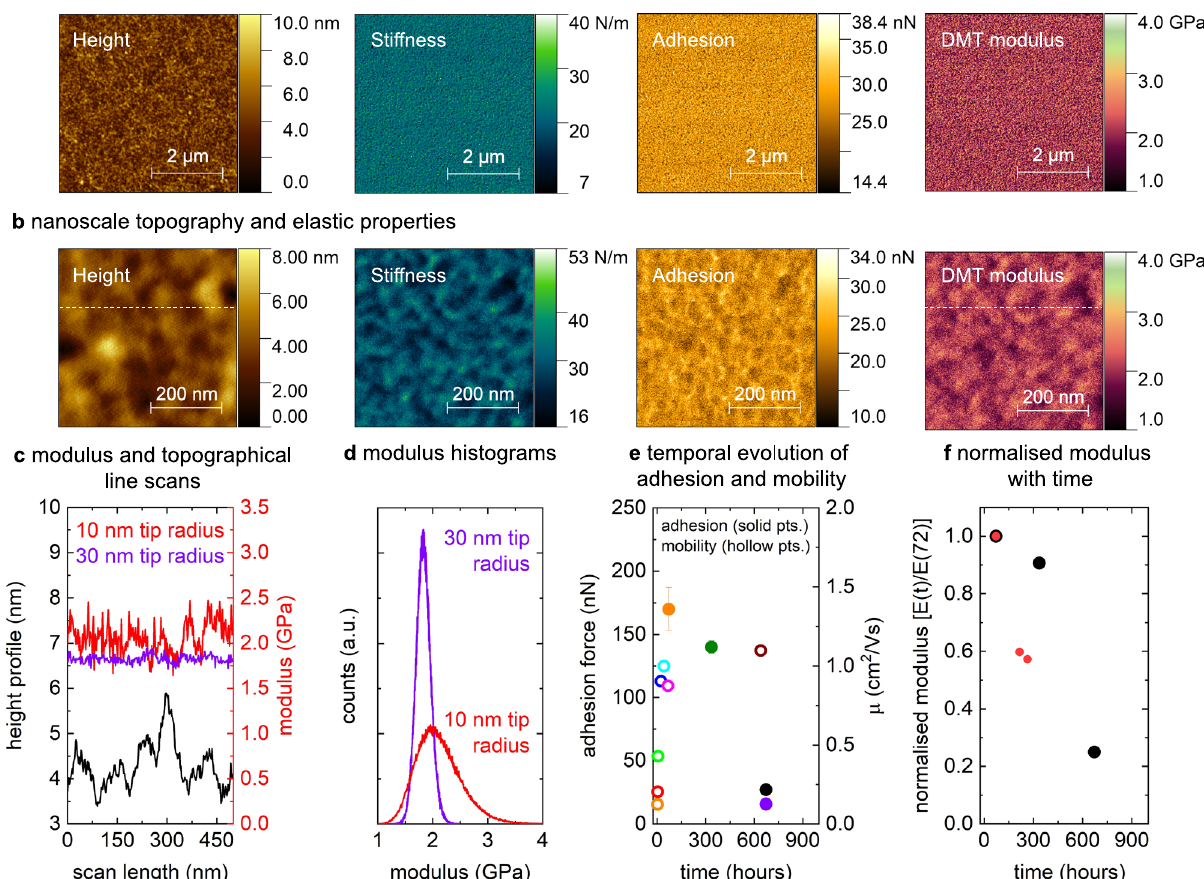
Fig. 4 Nanoscale mechanical properties and nanomechanical homogenization with time. a Topography and elastic properties (stiffness, adhesion, and modulus) in C16-IDTBT on the microscale. b Topography and elastic properties (stiffness, adhesion, and modulus) in C16-IDTBT on the nanoscale. The thin fi lms were processed under identical conditions as those used in the electrical and thermoelectric devices but were left undisturbed under ambient conditions and in the dark for several weeks to allow the low molecular weight solvent molecules to evaporate from the surface under their own volatility. c Line scan of the modulus and topography along the dotted white lines shown in (b) measured using a tip radius of 10 nm. A scan of the modulus with a tip radius of 30 nm is shown in purple for comparison 63 . d Comparison of modulus histograms measured with two different tip radii; a 30 nm tip radius (larger than ordered fi lm features) and a 10 nm tip radius (equivalent or less than ordered fi lm features). e Comparison showing how the fi lm adhesion changes far slower with time than the saturation mobility. f Normalized modulus measured on different C16-IDTBT samples using two different AFMs. The black dots correspond to the measurements on a Park Systems NX20 and the red dots correspond to measurements on a JPK NanoWizard 3 Atomic Force Microscope. The modulus reduction and homogenization that accompanies the reduction in adhesion force takes place on a time scale longer than the stabilization of the saturation